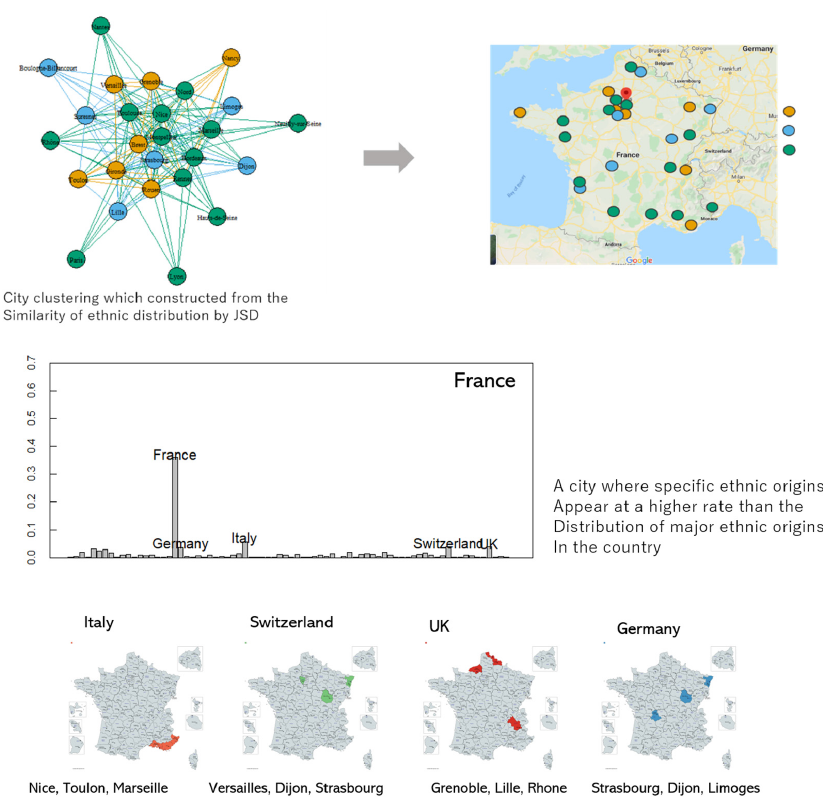
Figure 9 Spatial distribution of ethnicity in France. [33,34] Figure 9. Spatial distribution of ethnicity in France [32,33]. Information 2020 , 11 , x FOR PEER REVIEW